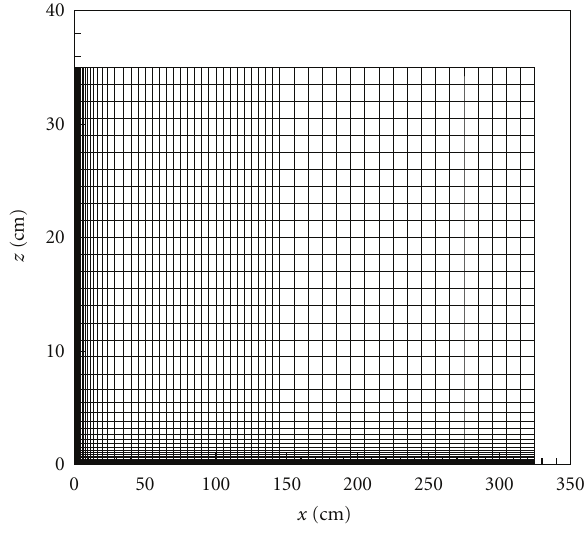
Figure 2: Mesh configuration.